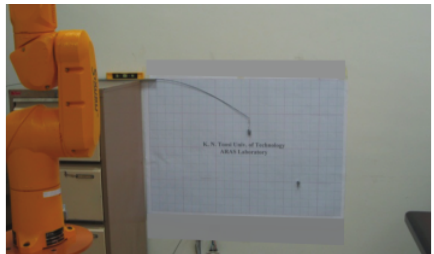
Figure 8: The experimental setup for dynamics tests.